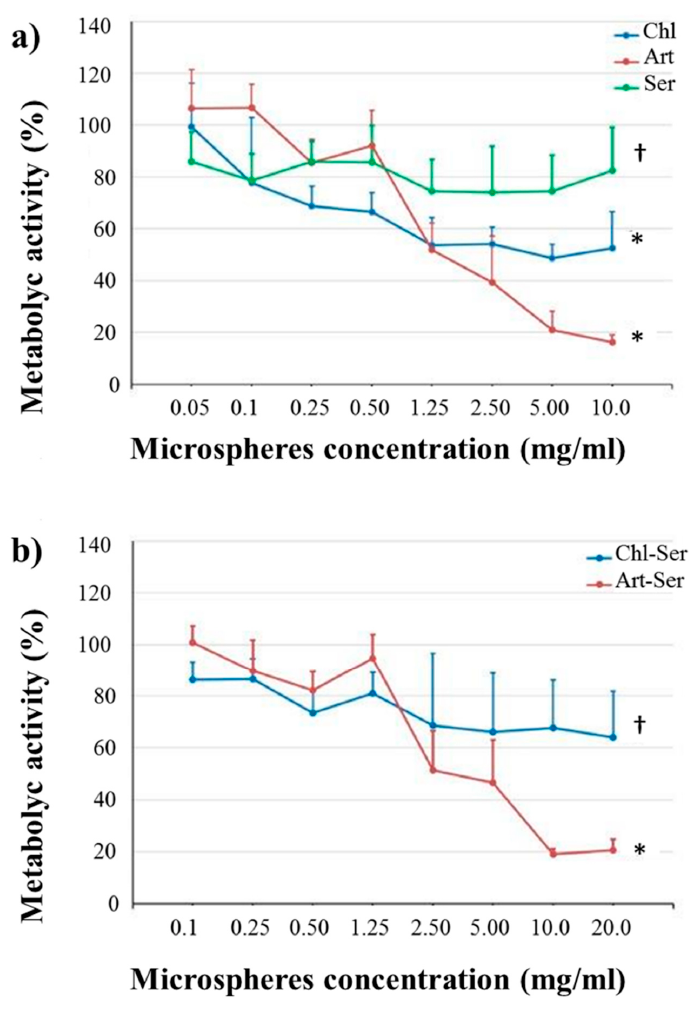
Figure 4. Mean values of cell metabolic activity (%) and standard deviations, considering (a) Chl (blue line), Art (red line) and Ser (green line) formulations and (b) Chl-Ser (blue line) and Art-Ser (red line) formulations. For each graph, different symbols († and *) indicate significant differences between formulations ( p < 0.05).